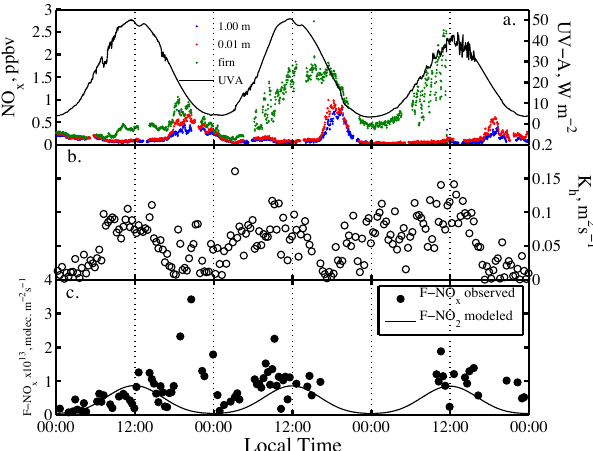
Fig. 8. Atmospheric mixing ratios of NO x and snow emissions dur- ing 18–21 January 2010. Shown are (a) mixing ratios above the snow and in firn air along with UV-A irradiance, (b) the turbulent diffusion coefficient of heat K h at 1m and (c) observed NO x flux compared to modelled potential NO 2 flux from nitrate photolysis (Reaction